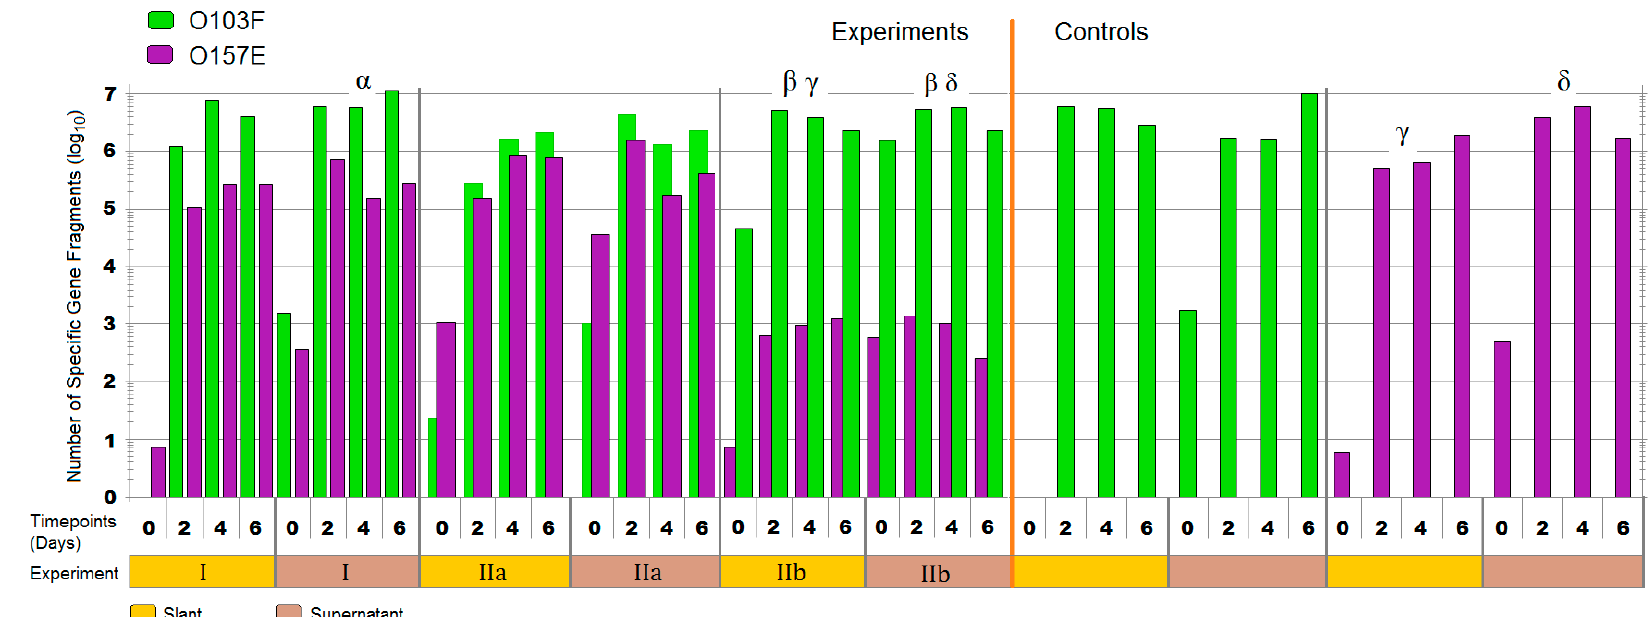
Figure 6. The total number of Escherichia coli O103F and O157E specific gene fragments in the supernatant and on the agar slant, across three plug ‘n’ prey experiments in comparison to the controls at each time point. Note: I = O103F and O157E added at the same time (bars side by side), IIa = O157E 3 h advantage over O103F (O157E bar on top), IIb = O103F 3 h advantage over O157E (O103F bar on top). Timepoint 0 is first time point after addition of both competitors. Symbols: α , β , γ , and δ denote a significant difference between: O103F and O157E in experiment I —supernatant, O103F and O157E in experiment IIb —slant and supernatant, O157E in experiment IIb and O157E control—slant and O157E in experiment IIb and O157E control—supernatant, respectively (<0.05).